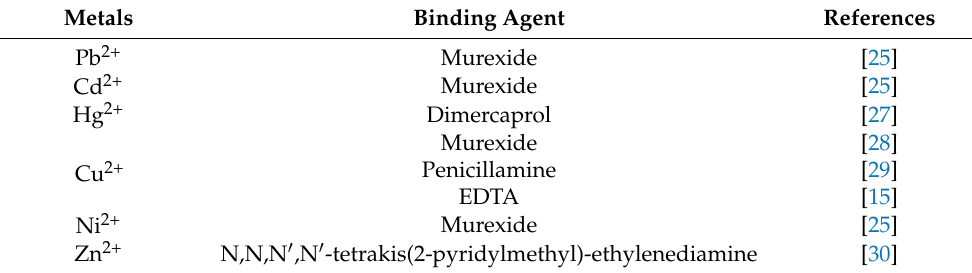
Table 1. Some metals and their chelating